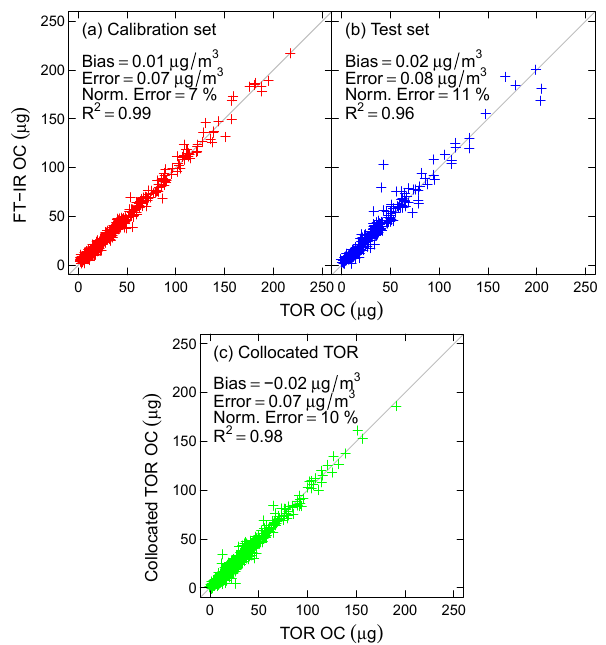
Figure 2. Predicted OC for calibration set (a) and test set (b) . The collocated TOR samples (c) are from sites with parallel quartz filters that are both analyzed by TOR. Only the Phoenix site has samples in the calibration, test and collocated data sets. There are 521 sam- ples in the calibration set (a) , 265 samples in the test set (b) and 431 samples in the collocated TOR data set (c) . Concentration units of µgm − 3 for bias and error are based on the IMPROVE nominal volume of 32.8m 3 . Table 1. MDL and precision for FT-IR OC and TOR.